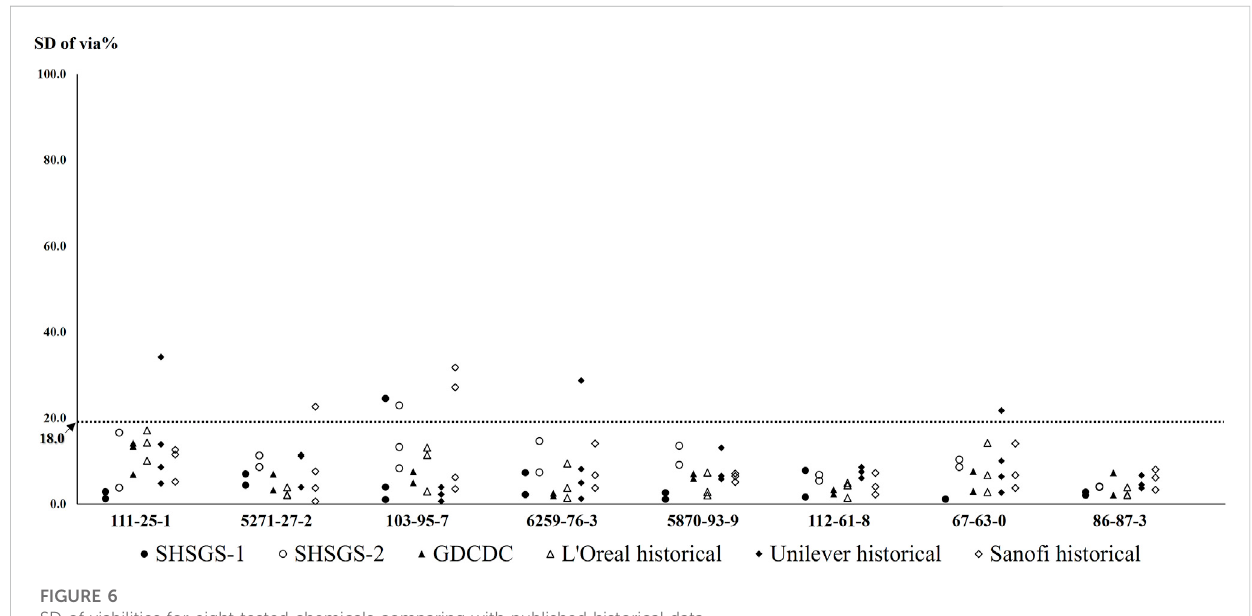
FIGURE 6 SD of viabilities for eight tested chemicals comparing with published historical